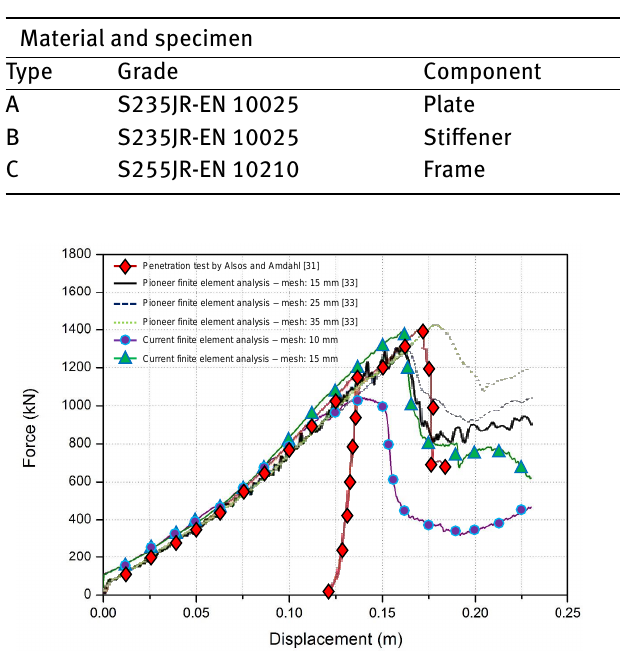
Figure 4. Comparisons of the validation with the penetration test (laboratory experiment) by [31] Figure 4: Comparisons of the validation with the penetration test and pioneer finite element simulation by [33]. (laboratory experiment) by [31] and pioneer finite element simula- tion by